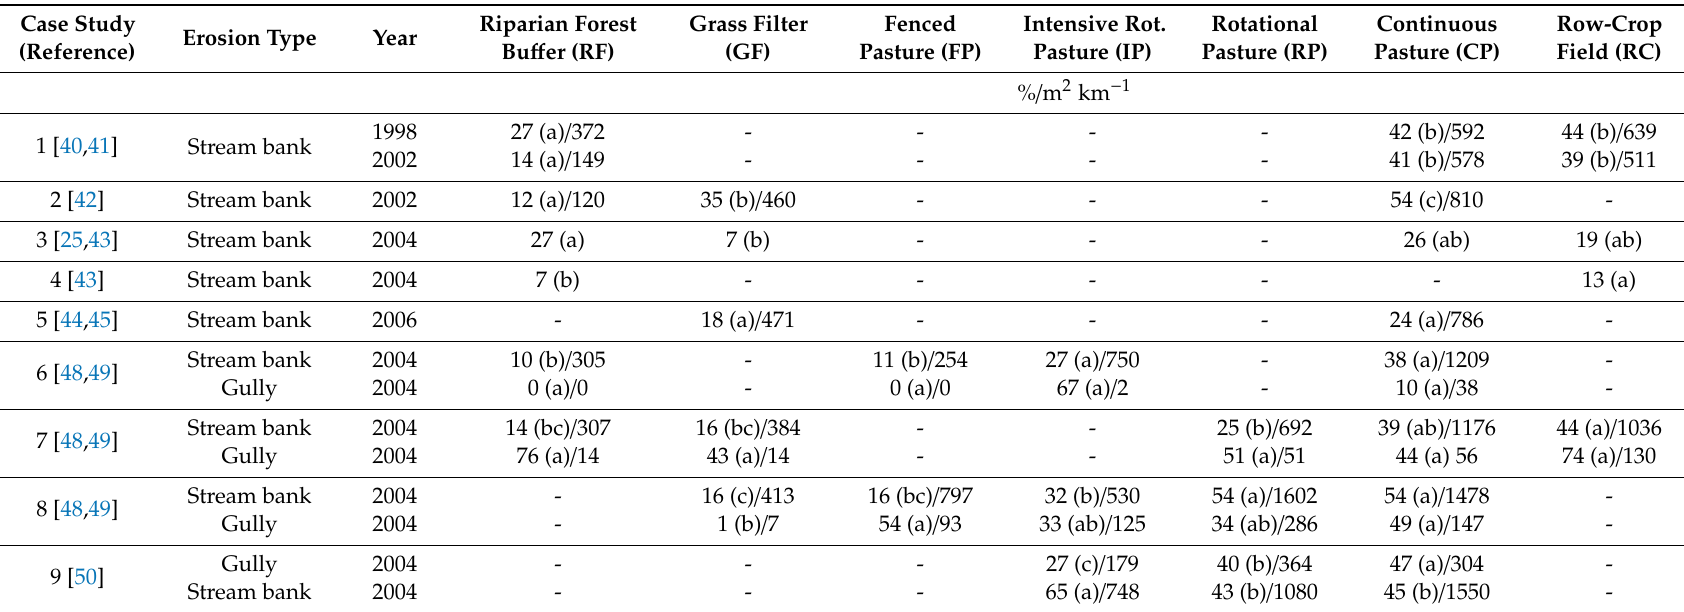
Table 3. Stream and gully severely eroding bank lengths (%) and areas per stream length (m 2 km − 1 ) adjacent to di ff erent riparian land-uses from di ff erent studies conducted in Iowa. This percentage is estimated by dividing the severely eroding bank length by the total length. The di ff erent letters in parenthesis